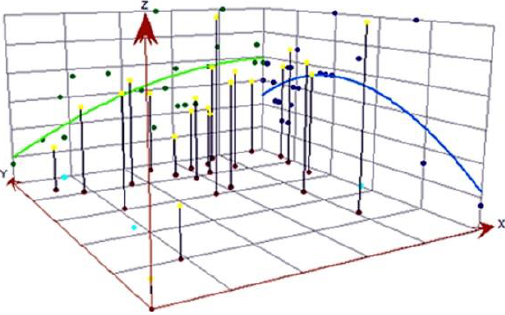
Figure. 9. The experiment of spatial variation of trend analysis of SM using point project attribute data.